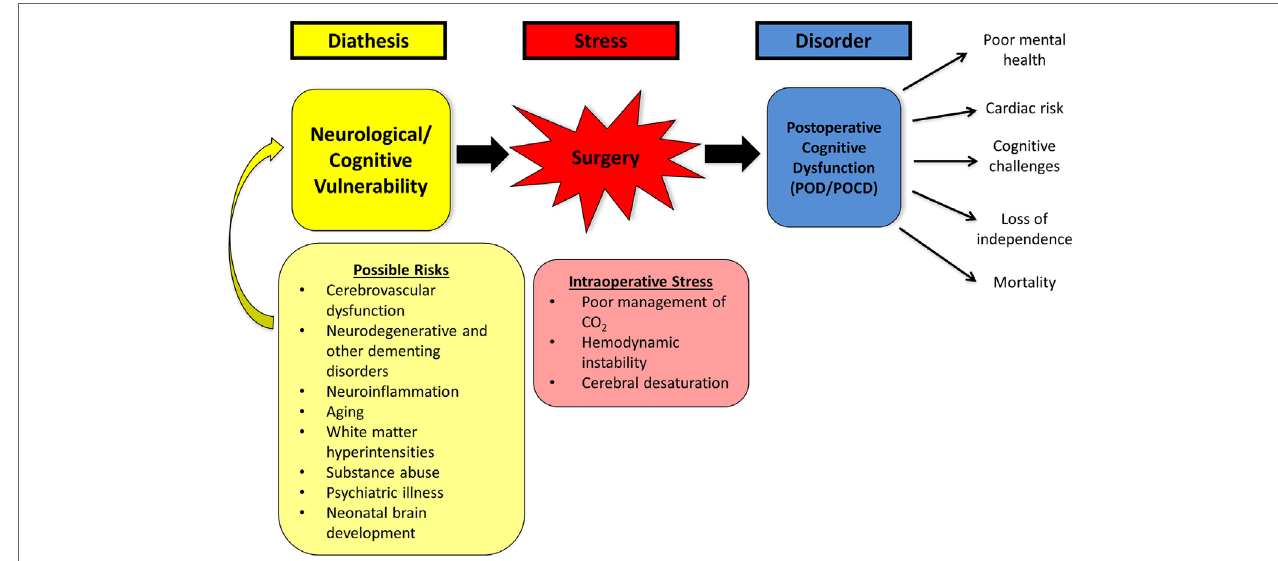
FiGUre 3 | Diagrammatic depiction of the stress–diathesis model for postoperative delirium (POD). See the text for further